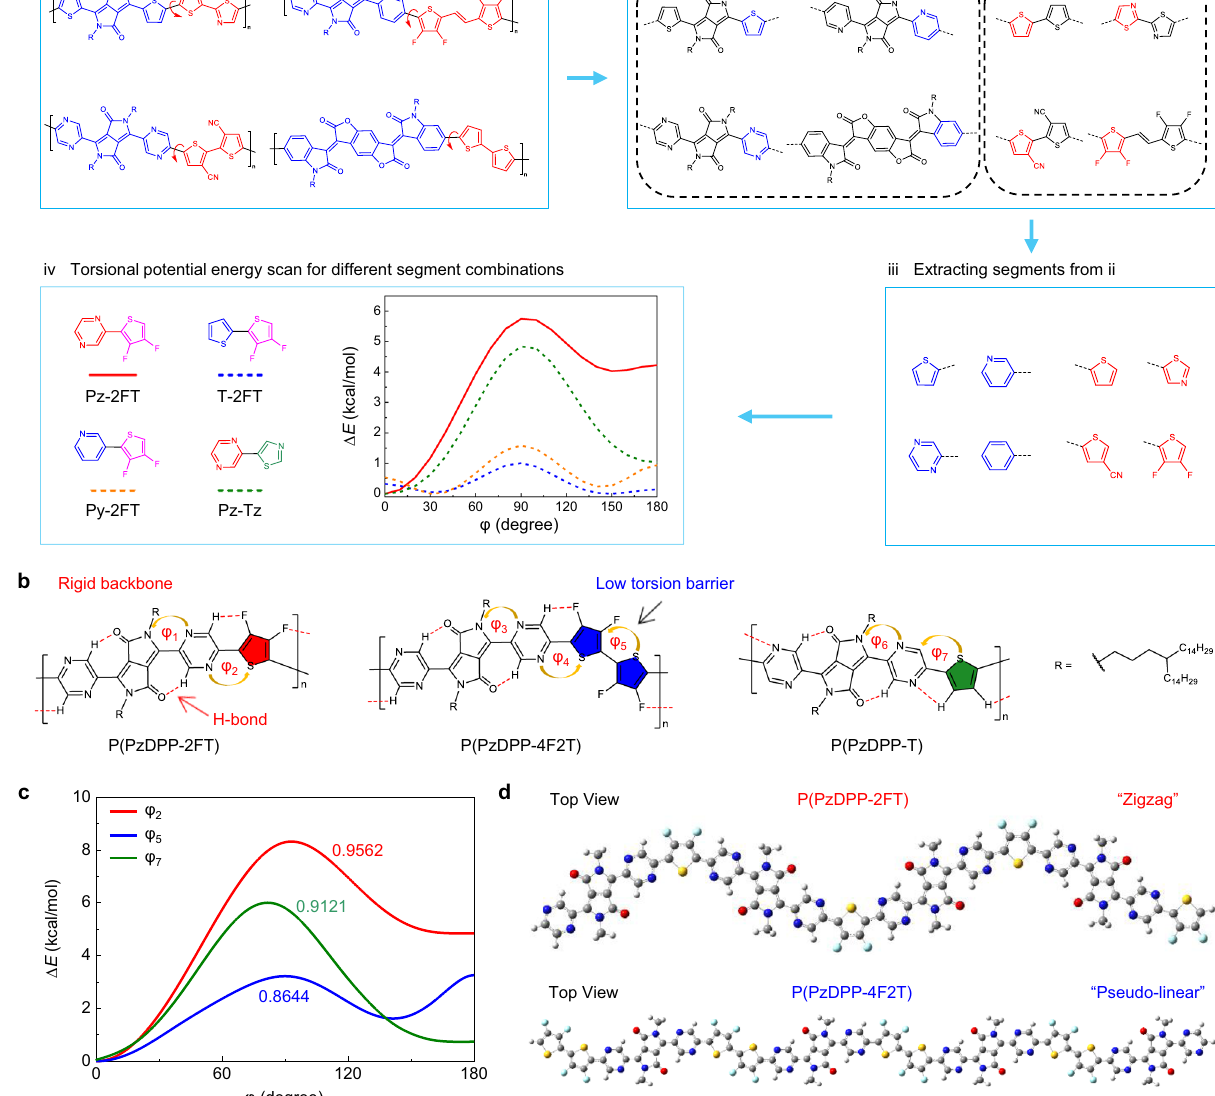
Fig. 1 Computer-aided polymer design. a Computer-aided polymer building block screening process: (i) Collecting representative high-performance D – A copolymers used for OFETs; (ii) extracting building blocks; (iii) further extracting the segments for simplifying the screening process; (iv) PES of the dihedral angles of different segment combinations. ( b ) Chemical structures of P(PzDPP-2FT), P(PzDPP-4F2T), and P(PzDPP-T). c PES results of the torsional angles φ 2 , φ 5 , and φ 7 in these three polymers ( ω B97X-D/6-311G(d,p)). The energy is relative to the minimal energy conformer. Planarity indices 〈 cos 2 φ 〉 of these torsional angles were calculated based on PES results. d The DFT-optimized geometries of the tetramers of P(PzDPP-2FT) and P(PzDPP- 4F2T). Long alkyl chains were replaced with methyl